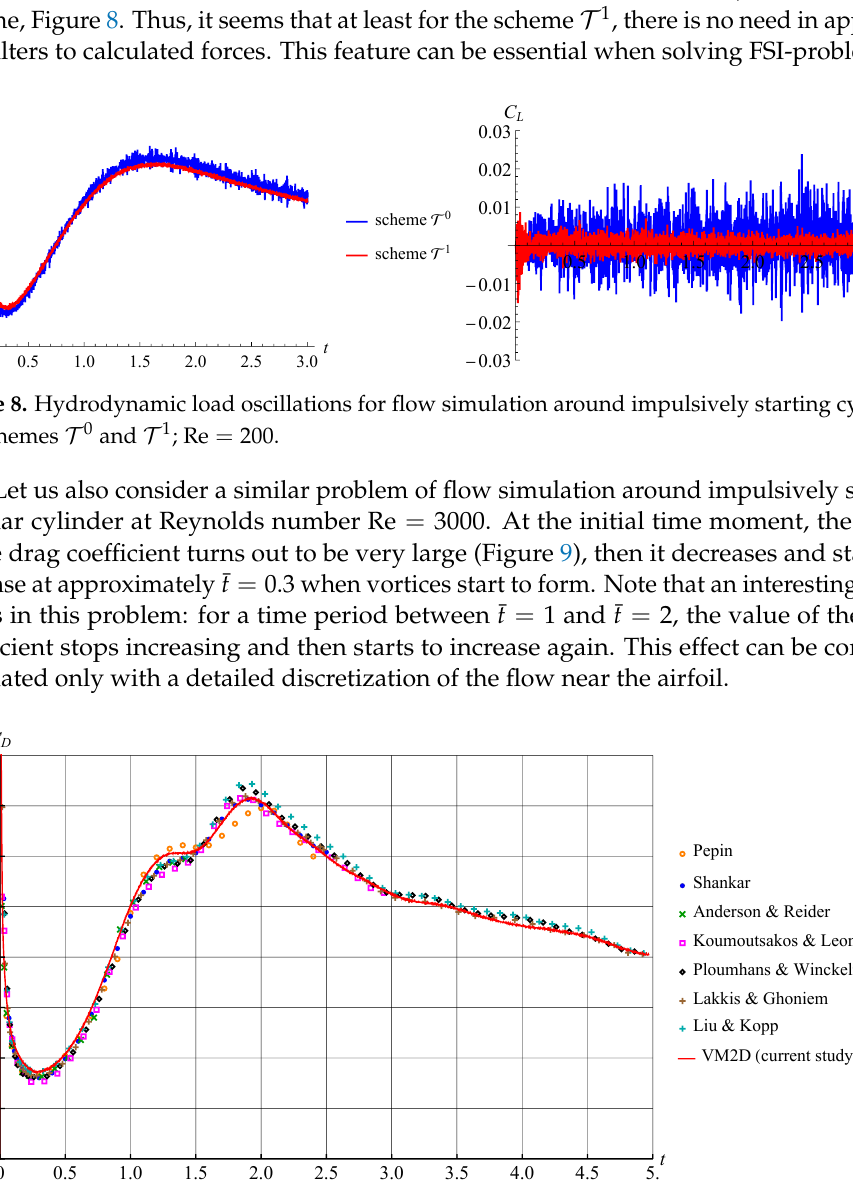
Figure 9. Unsteady drag force coefficient for the impulsively started circular cylinder at Re =